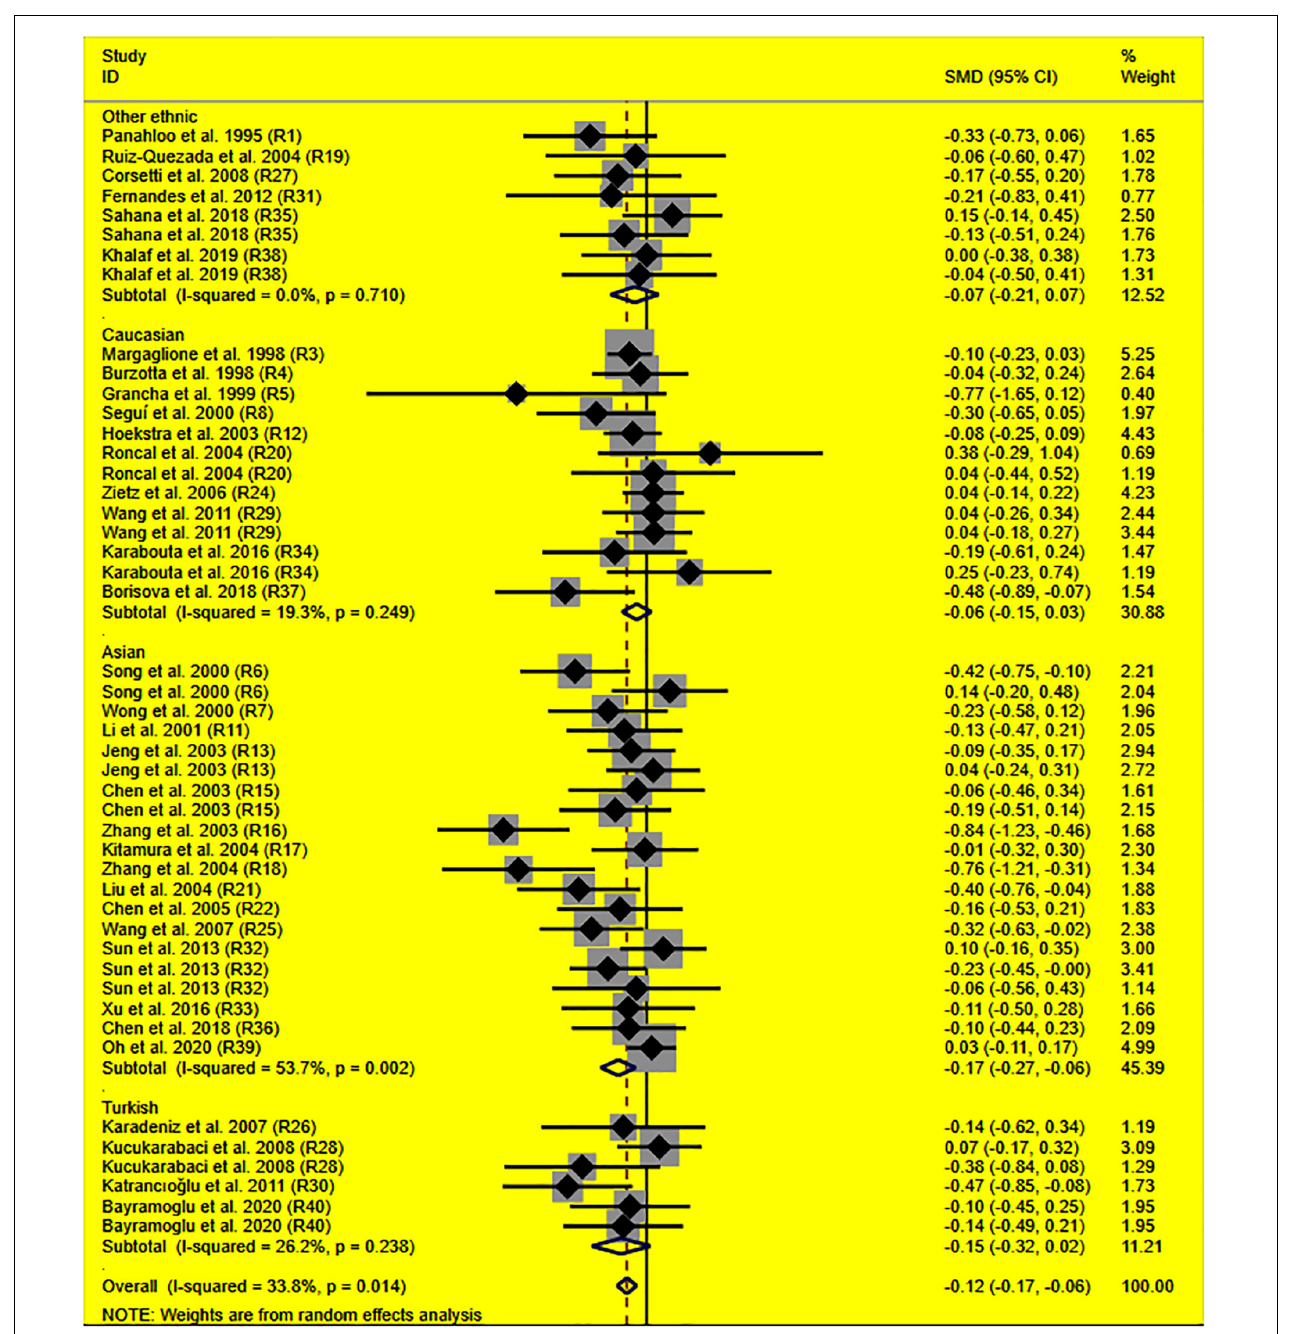
FIGURE 3 | Forest plot of the meta-analysis between SERPINE1 rs1799889 polymorphism and circulating TC levels.